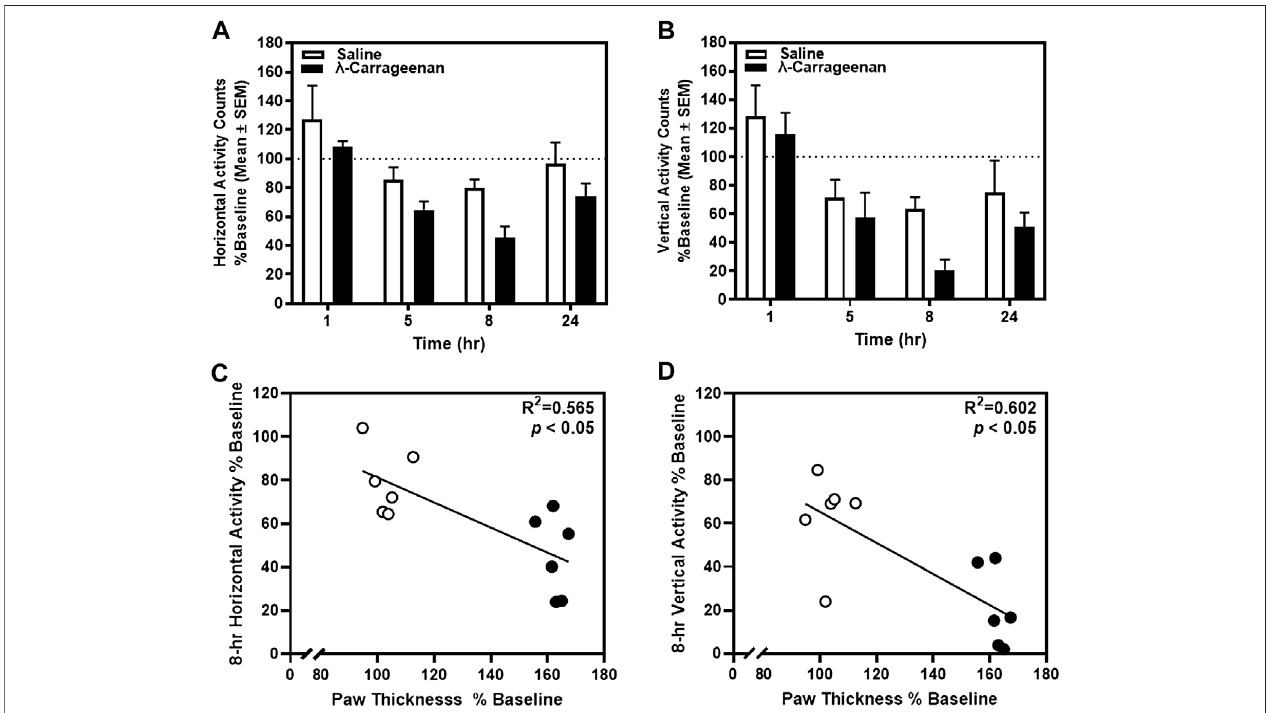
FIGURE 3 | The effect of λ -carrageenan (1%; i.p.l.) on locomotor activity is presented. Percent baseline horizontal and vertical activity for individual rats was calculated asthemean value at each time point followingtreatmentwith saline (white bars)or λ -carrageenan (black bars), normalizedtobaselinevalue. Thetimecourses of horizontal (A) and vertical (B) activity are presented. Paw thickness negatively correlated with horizontal (C) and vertical (D) activity at the 8 h timepoint.